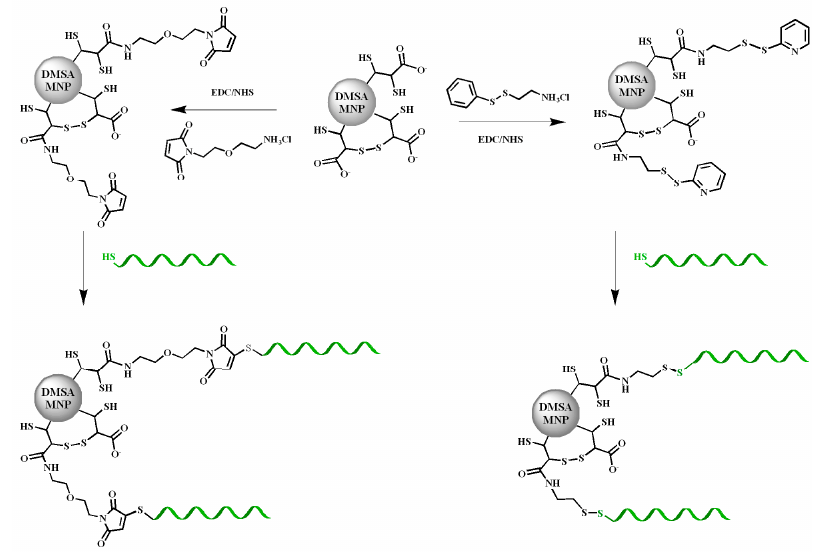
Figure 2. Schematic representation of the functionalization of SPIONs nanoparticles with TBAs (in green), using the two type of linkers maleimide ( left ) and disulfide ( right